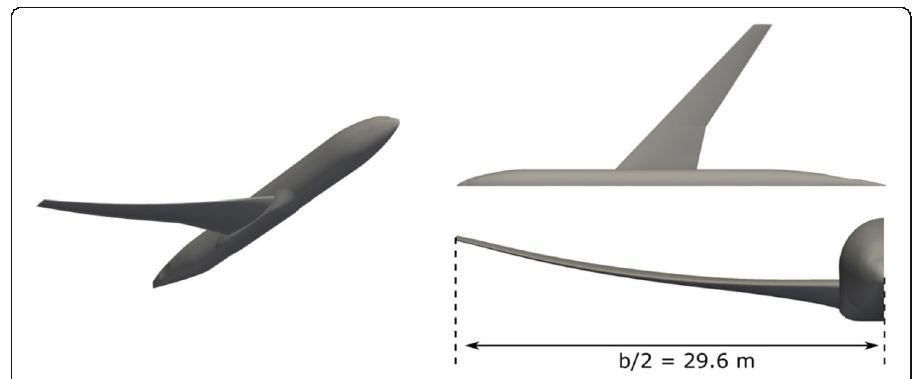
Fig. 1 The half model of the wing-body NASA CRM